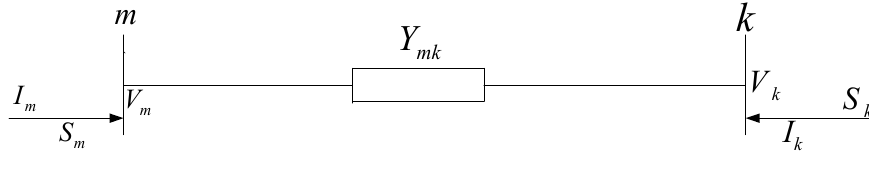
Figure 1. Single line diagram of a two bus power system.